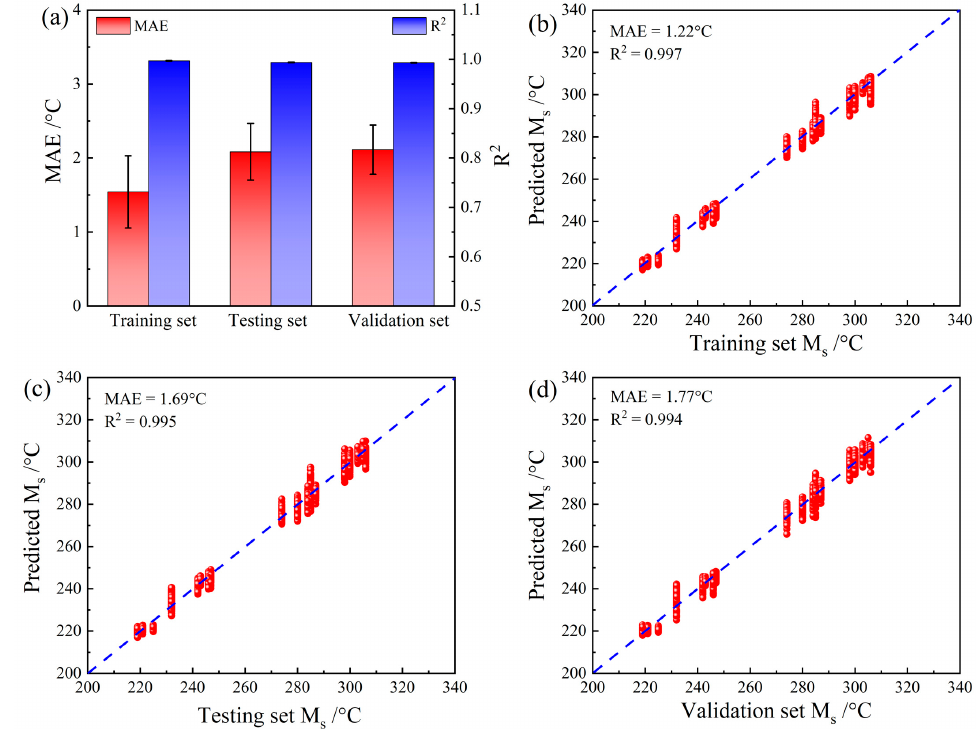
Figure 6. Results of Ms prediction using the CNN: ( a ) comparison of MAEs and R 2 values, ( b ) results of the training set, ( c ) results of the testing set, and ( d ) results of the validation set.